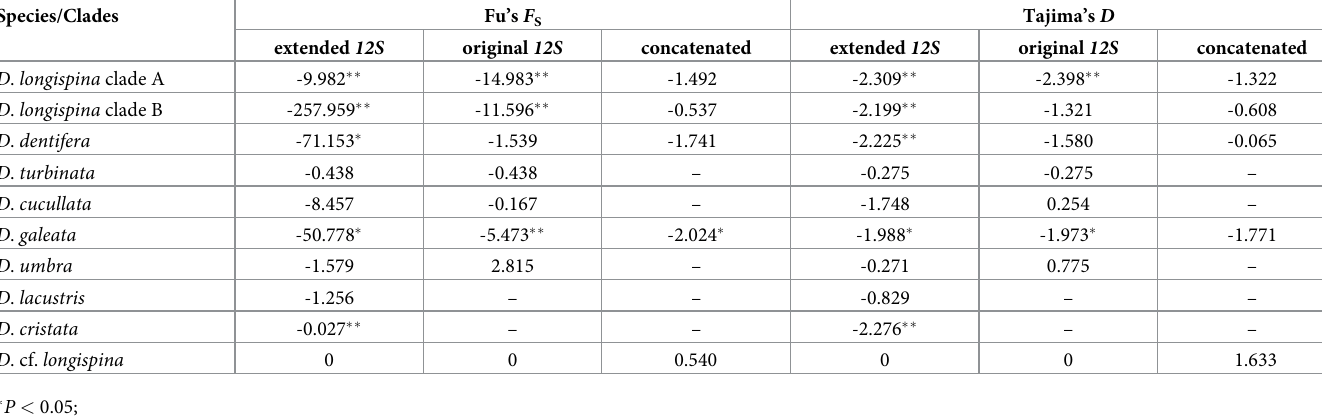
Table 5. The neutrality tests based on extended and original 12S datasets and the concatenated 12S + 16S + ND2 dataset of the mitochondrial DNA for species of the D . longispina complex.